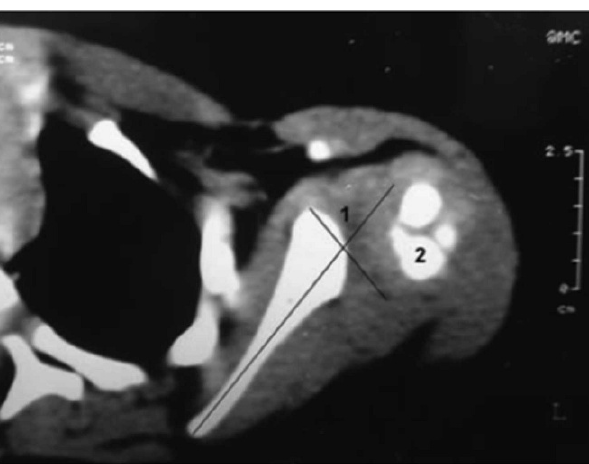
Figure 1 - Preoperative CT scan. Glenoid cavity (1) and humeral heal dislocated posteriorly (2).